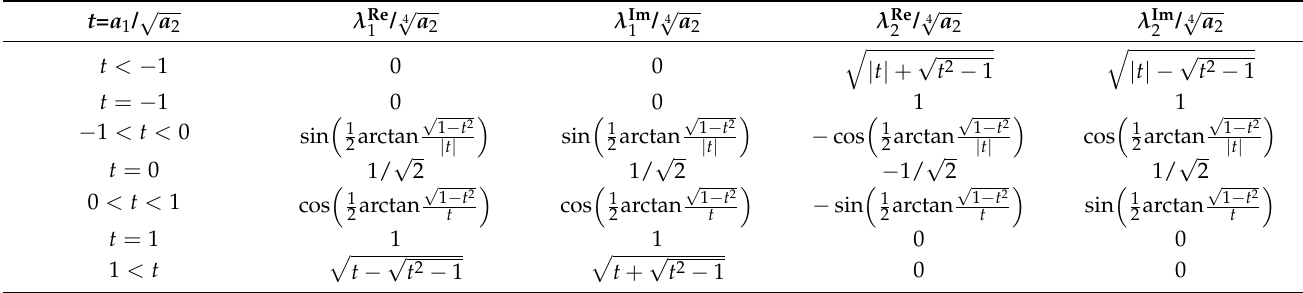
√ √ a 2 and λ Im a 2 , j = 1,2, of / 4 / 4 j j